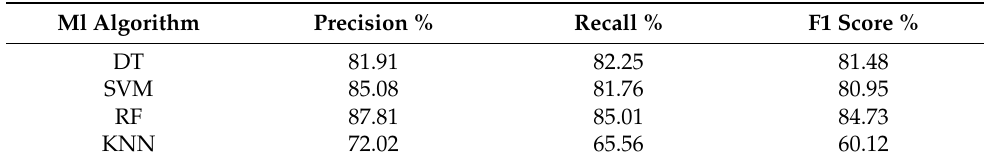
Table 5. Performance of bigram stacked auto